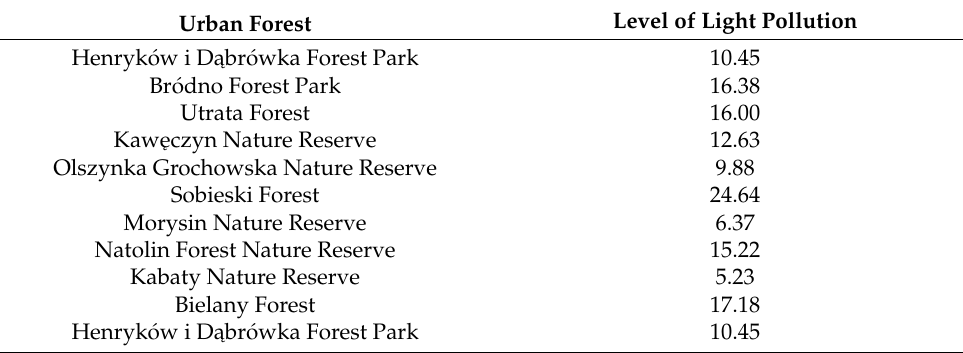
Table A2. Mean light pollution level (based on Visible Infrared Imaging Radiometer Suite